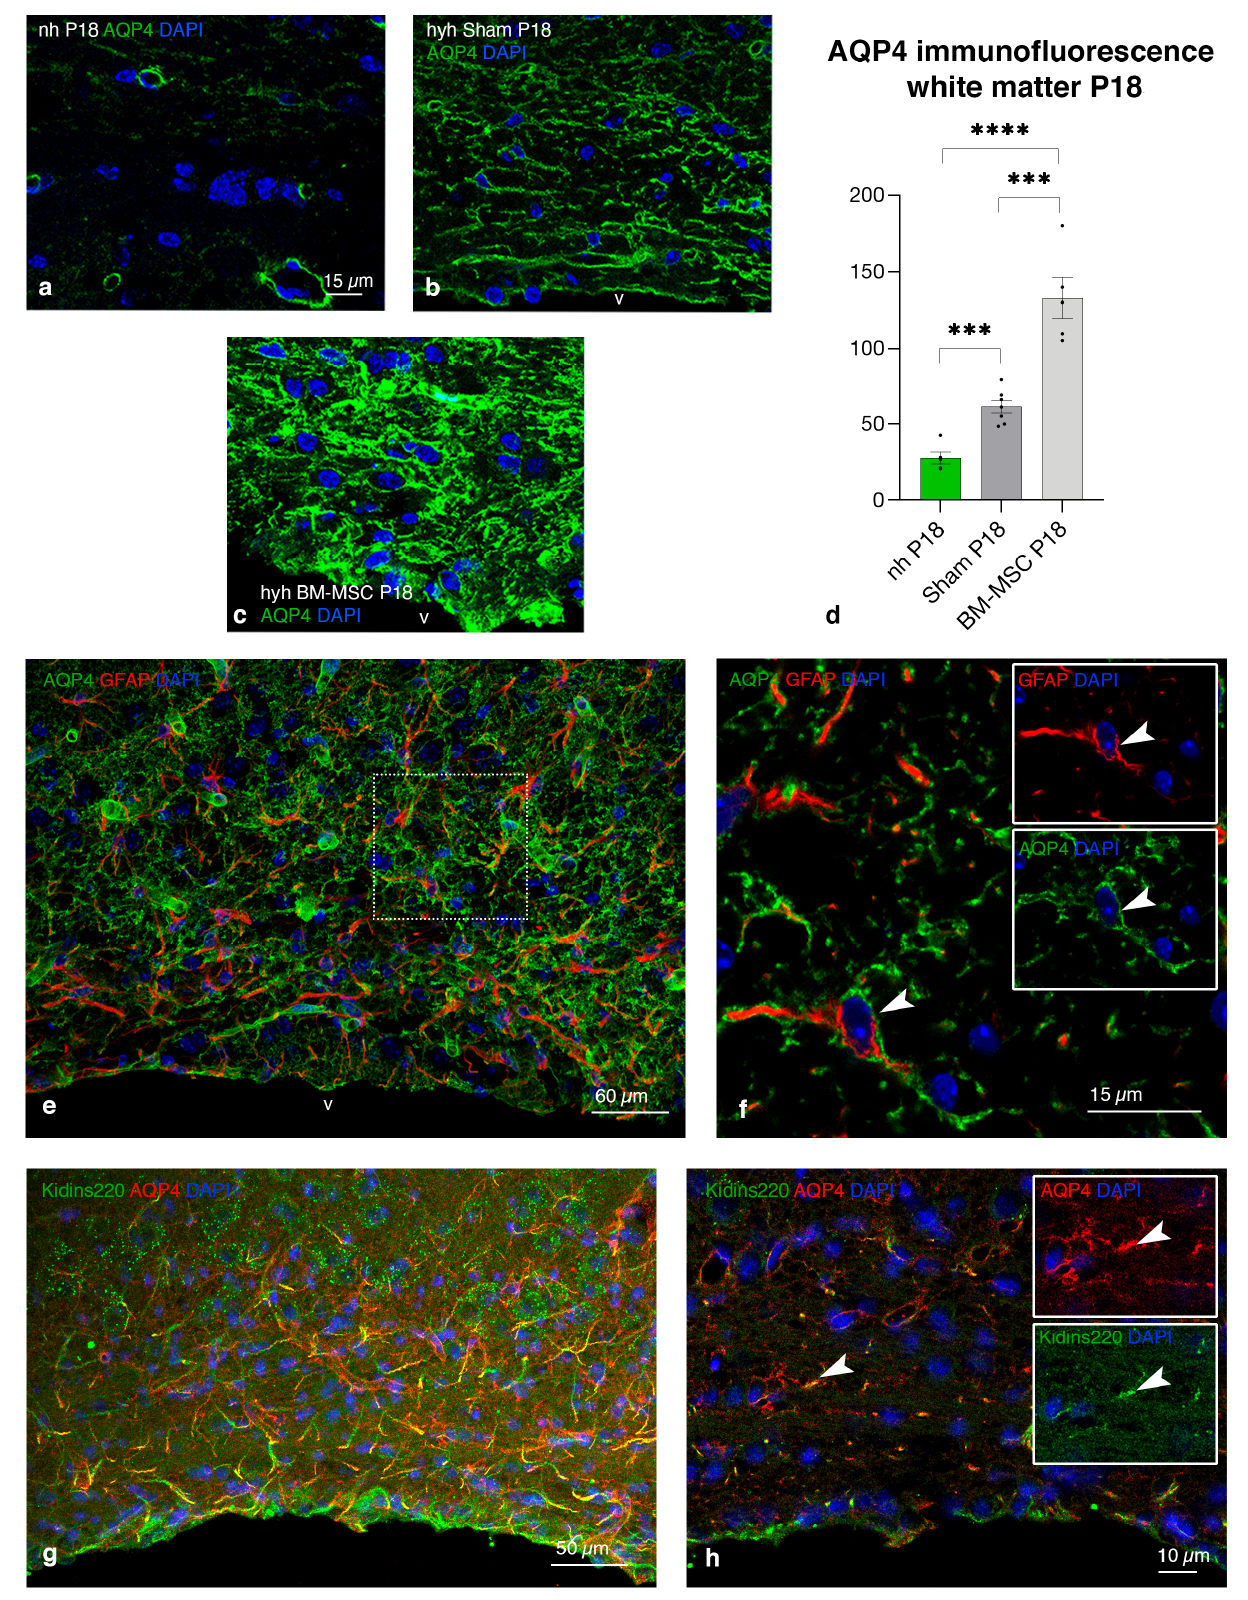
Figure 7. Increased expression of AQP4 and Kidins220 colocalization in the periventricular white matter of hydrocephalic mice treated with BM-MSCs at P18. ( a – d ) Immunofluorescence intensity